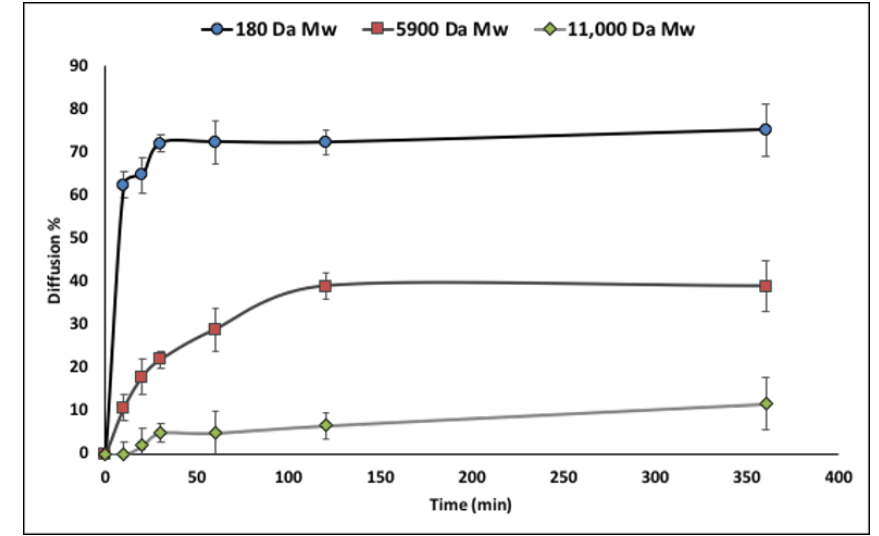
Figure 4. Diffusion rate of pullulan 180 Da Mw, 5900 Da Mw, and 11,000 Da Mw through Figure 4. Di ff usion rate of pullulan 180 Da Mw, 5900 Da Mw, and 11,000 Da Mw through microcapsule microcapsule membrane at different timing points. membrane at di ff erent timing points.